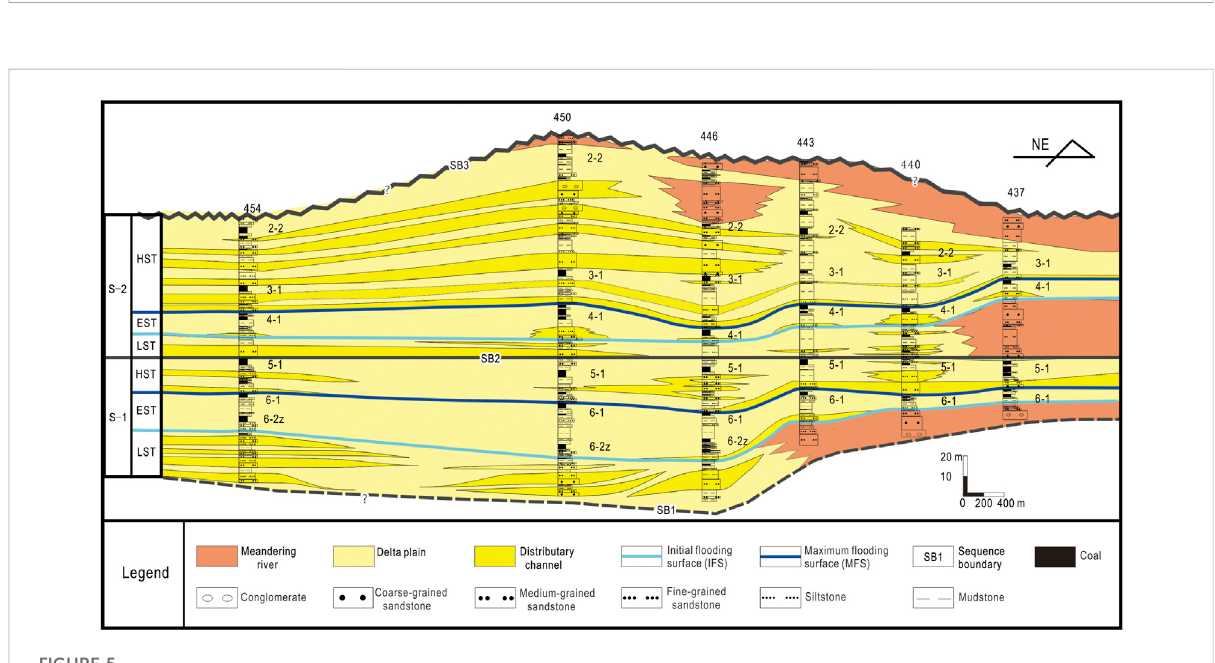
FIGURE 5 NE-SW cross-section (B-B ′ ) through the Yan ’ an Formation, showing lithofacies, interpreted depositional environments (including coal seams)